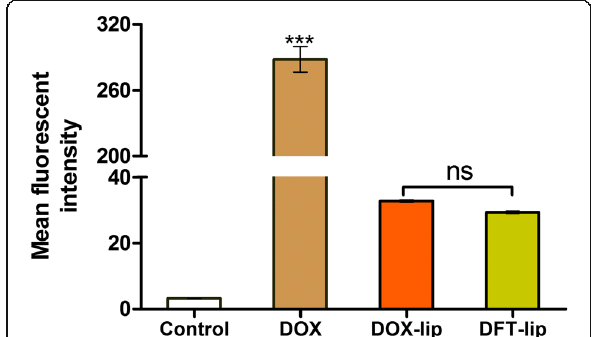
Fig. 4 Flow cytometric measurement of cellular uptake by breast cancer MDA-MB-231 cells after incubation with free DOX, DOX-lip, and DFT-lip at a concentration of 5 μ M DOX for 4 h at 37 °C. The auto-fluorescence of cells was applied as the control. All the data presented here were calculated as mean ± SD ( n = 3). Notes: ns, p > 0.05; *** p < 0.001